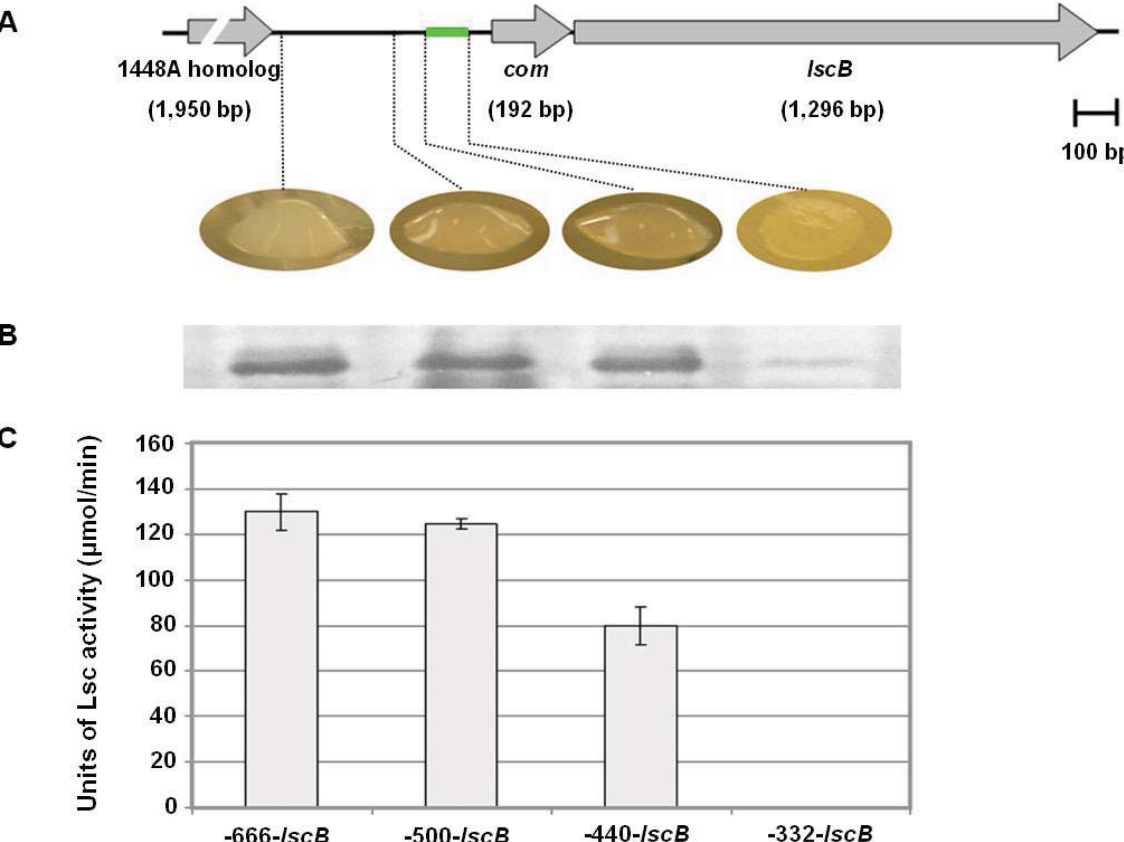
Figure 3. Nested deletion analysis of the lscB upstream sequence. ( A ) Schematic presentation of lscB and its upstream sequence. (